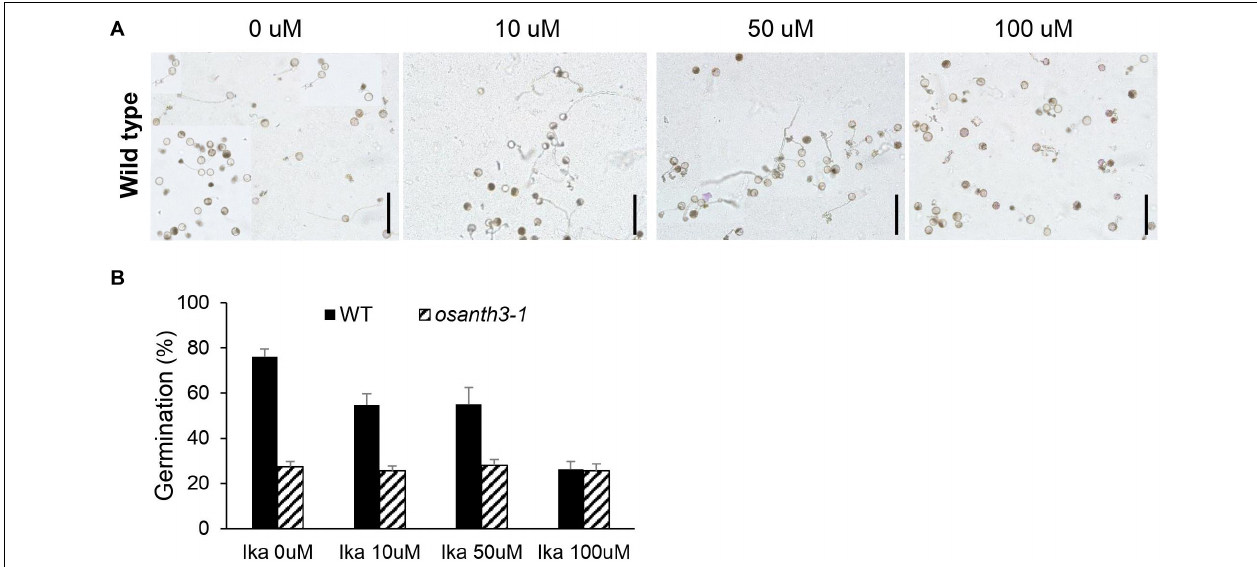
FIGURE 6 | Rice pollen germination percentage and clathrin-mediated endocytosis patterns under Ikarugamycin (IKA) treatment at varying concentrations. (A) Images of rice pollen placed in germination media with different concentrations of IKA (0, 10, 50, and 100 µ M). All media contained 0.2% dimethyl sulfoxide (DMSO). Bars = 200 µ m. (B) Germination percentage of the wild-type and osanth3-1 plants at different IKA concentrations. Germination rate was calculated with three replicates (each of the replicates was calculated for n >